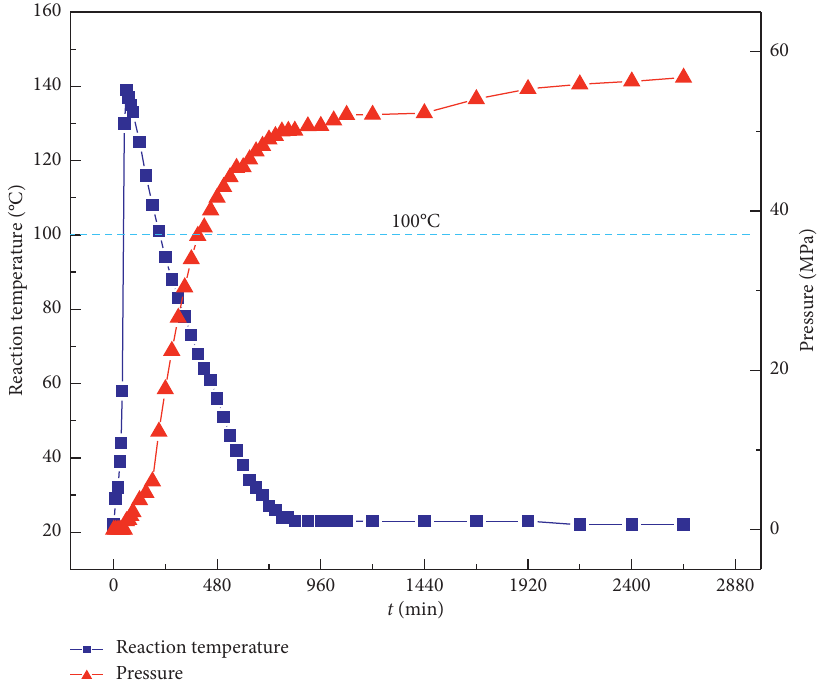
Figure 3: Temperature and expansion pressure during static